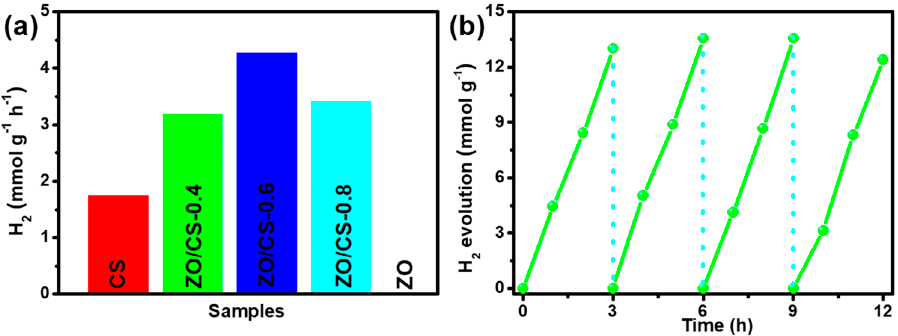
Figure 7. ( a ) Photocatalytic H 2 production rates of as − prepared photocatalysts. ( b ) Cycling stability for the ZO/CS − 0.6.